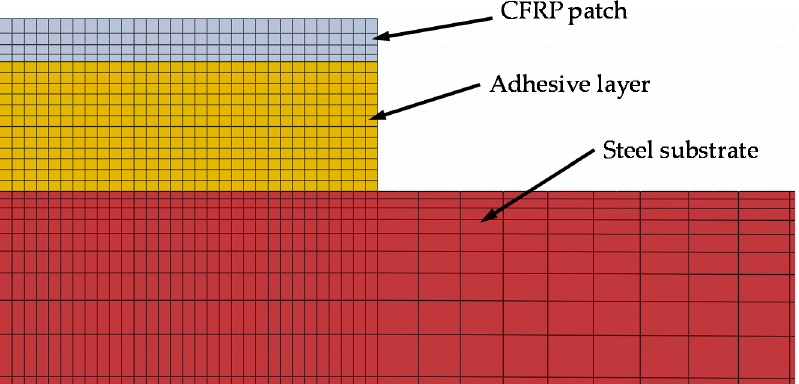
Figure 5. A typical mesh pattern used for DSJ models.